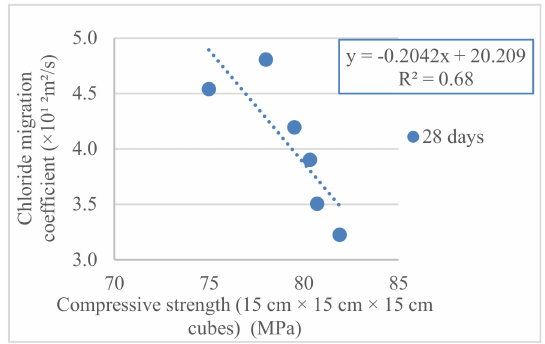
Figure 14. Relationship between chloride migration and compressive strength (15 cm × 15 cm × 15 cm cubes) results at 28 days.